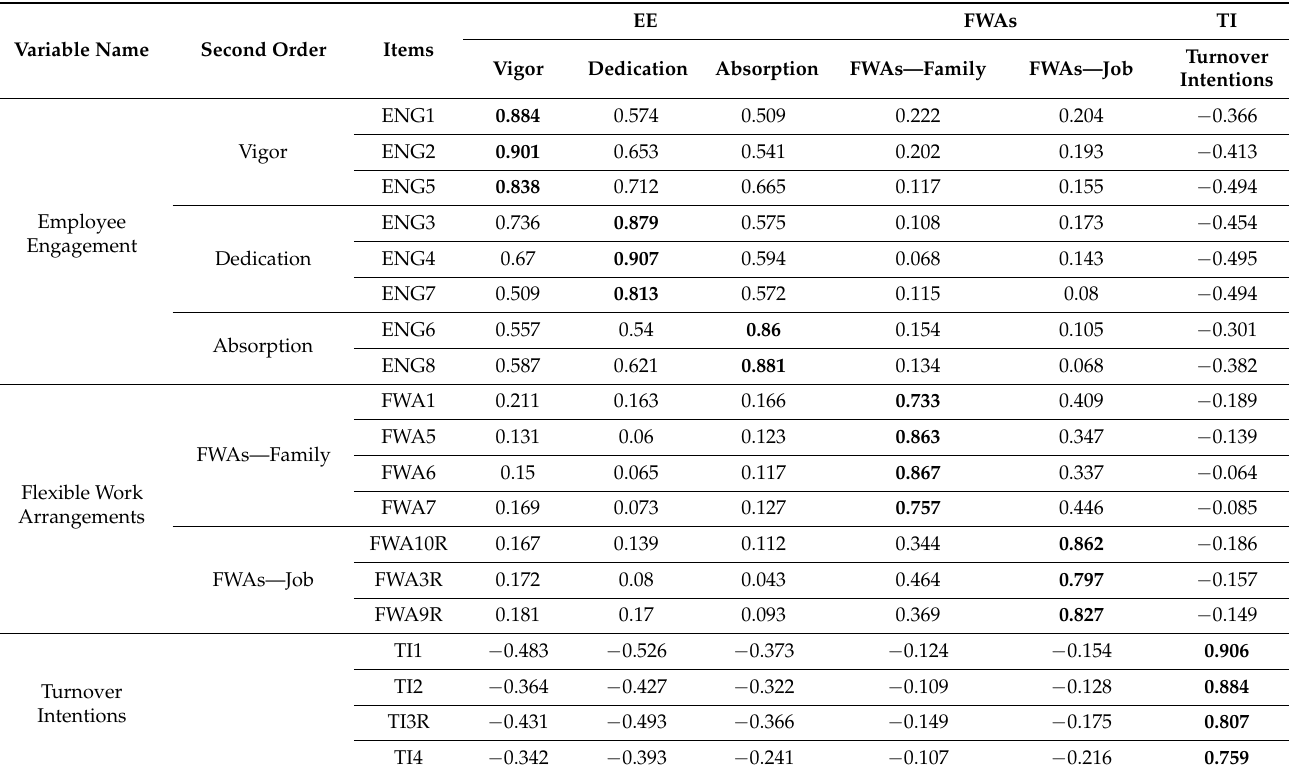
Table 8. Discriminant validity (cross-loadings).